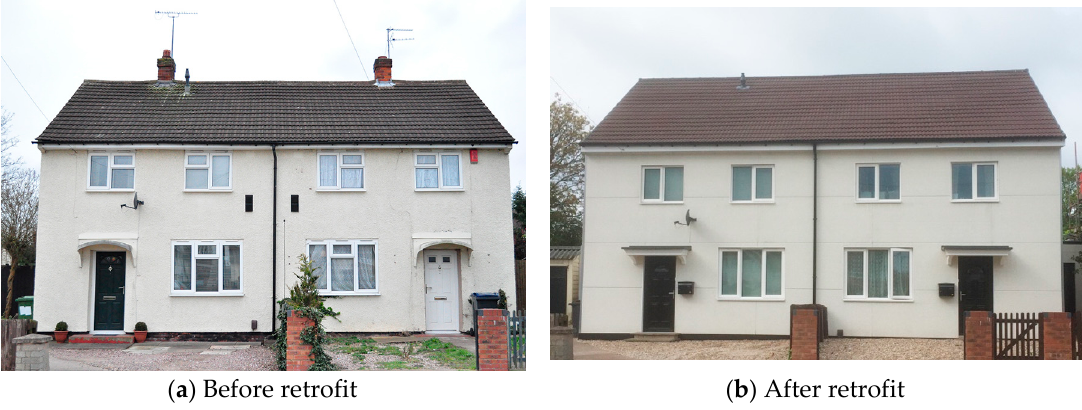
Figure 10. Two semi-detached houses in the RetrofitPlus project.